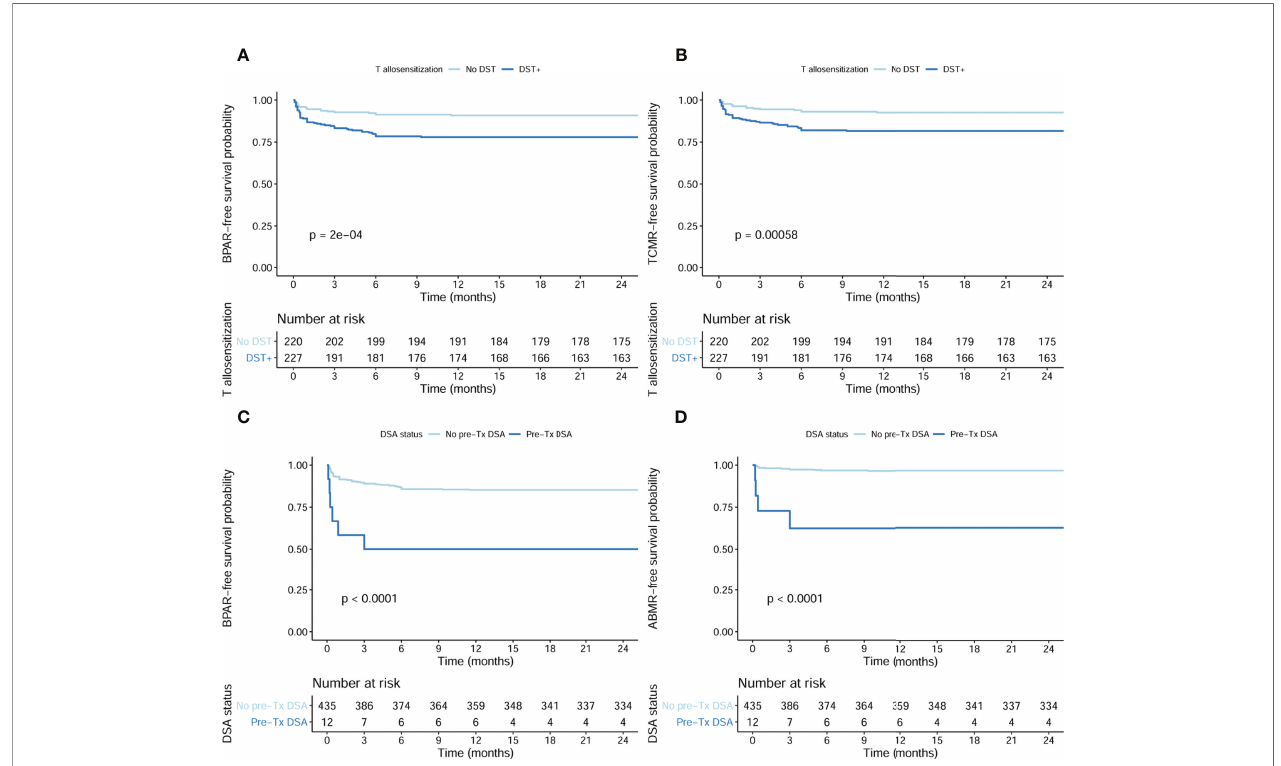
FIGURE 4 | Incidence of BPAR in presence of pretransplant DSTs and DSAs in the whole population (n = 447). (A) Kaplan – Meier BPAR-free survival curves according to pretransplant DSTs (log rank <0.001). The incidence of BPAR was 50/227 (22%) in DST+ patients, whereas only 20/220 (9.1%) DST − developed BPAR, p < 0.001. (B) Kaplan – Meier TCMR-free survival curves according to pretransplant DSTs (log rank <0.001). The incidence of TCMR was 41/227 (18.1%) in DST+ patients, whereas only 16/220 (7.3%) DST − developed TCMR, p = 0.001. (C) Kaplan – Meier BPAR-free survival curves according to pretransplant DSAs (log rank <0.001). The incidence of BPAR was 6/12 (22%) in DSA+ patients, whereas only 64/435 (14.7%) DSA − developed BPAR, p = 0.001. (D) Kaplan – Meier ABMR- free survival curves according to pretransplant DSA (log rank <0.001). The incidence of ABMR was 4/12 (33.3%) in DSA+ patients, whereas only 14/435 (3.2%) DSA